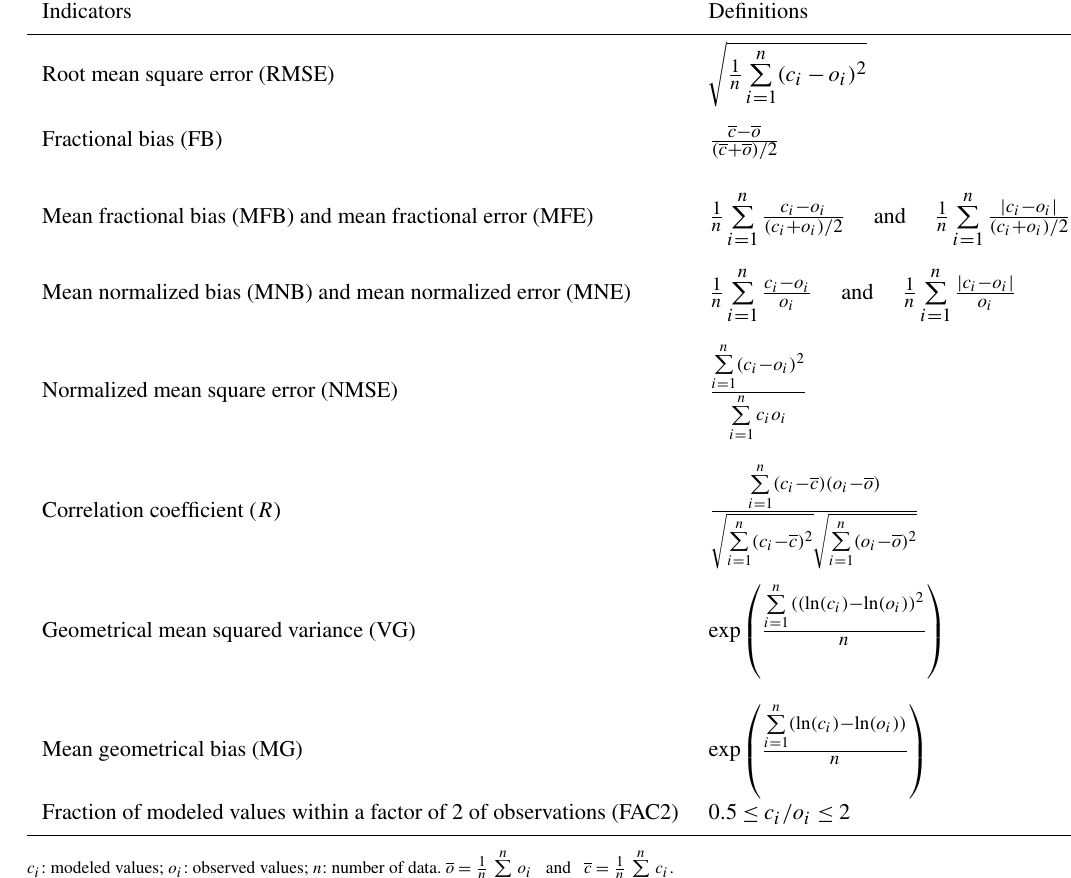
Table A1. Definitions of the statistical